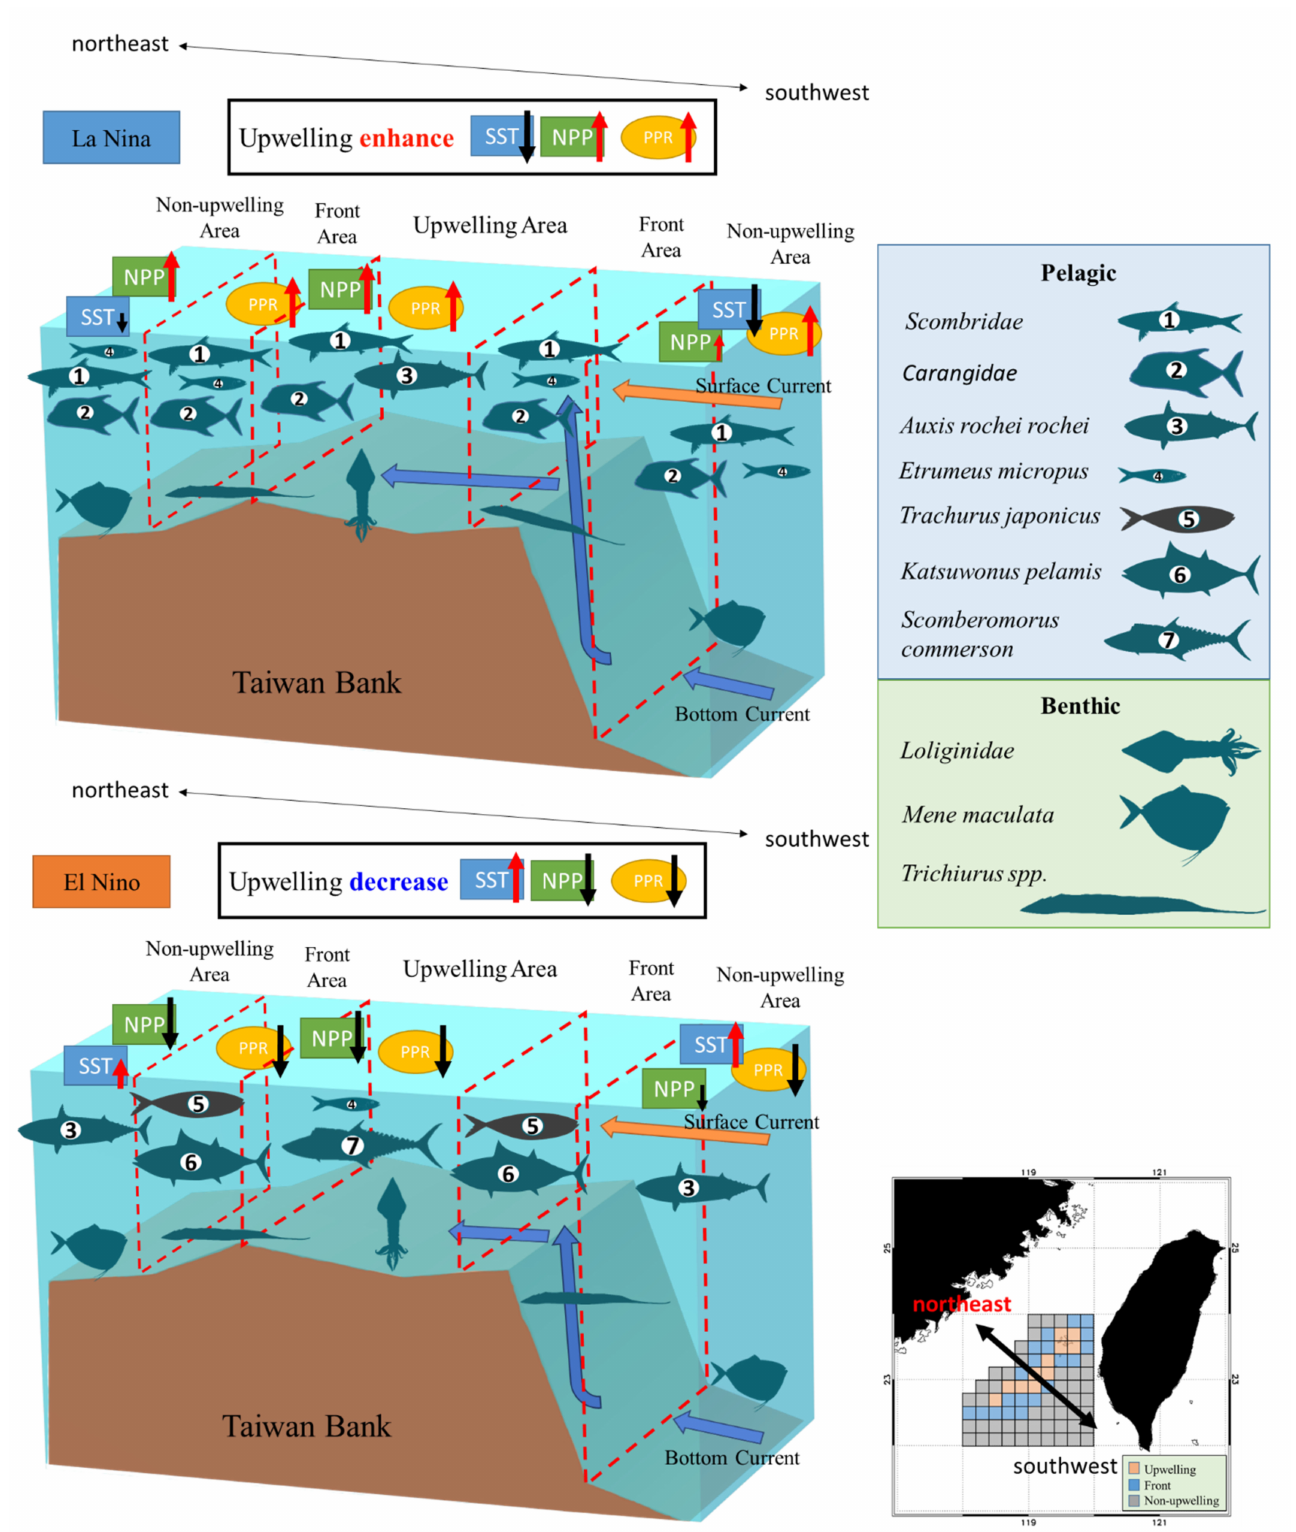
Figure 11. The fishery resource structures on the three ecosystem habitats of Taiwan Bank in El Nino and La Nina